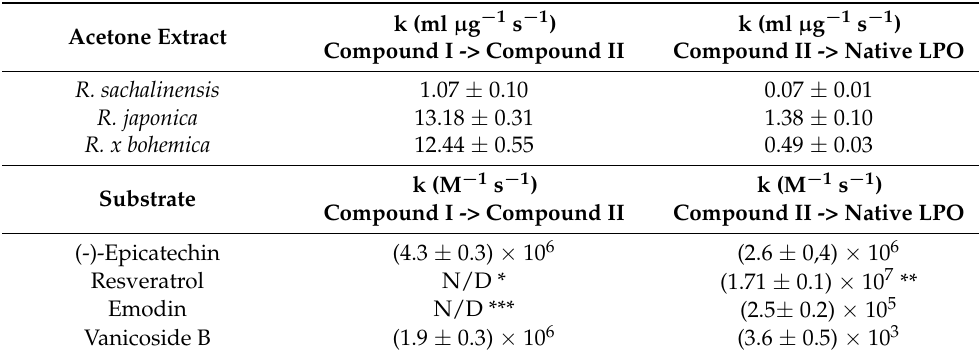
Table 3. Apparent second-order rate constants for the reaction of selected extracts and polyphenols with LPO Compounds